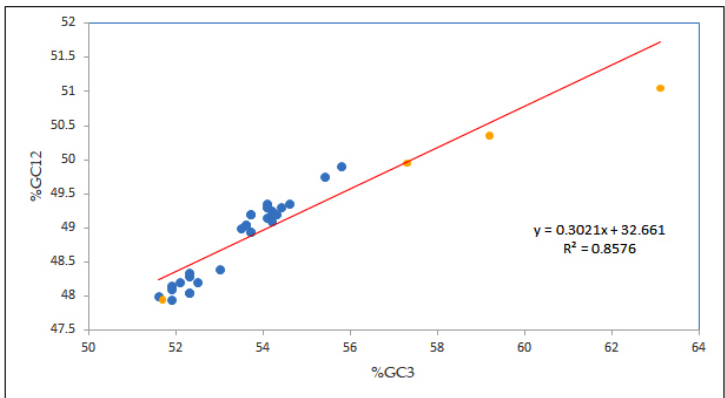
Figure 4. Neutrality plot analysis (GC12 vs. GC3) for the entire coding sequences of EPB41L3. GC12 stands for the average value of GC contents at the first and second positions of the codons (GC1 and GC2), while GC3 refers to the GC contents at the third codon position. The red line is the linear regression of GC12 against GC3, R = 0.926, relative neutrality is 30.21%. The blue dots are assigned for Homo sapiens while the yellow dots are assigned for other